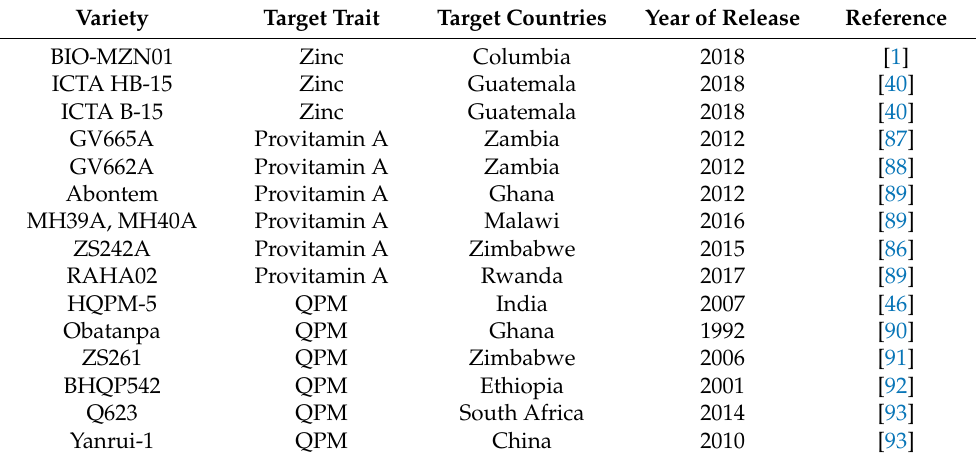
Table 2. List of some of the provitamin A, Zn and QPM biofortified maize varieties released in differ- ent countries across the